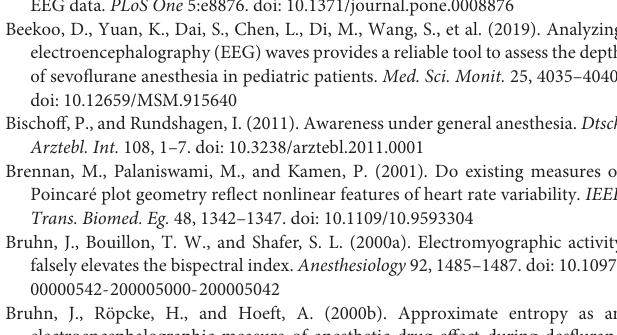
Supplementary Figure 1 | Total EEG power and Poincaré plot parameters throughout the time course from the hypnotic condition to the awake state in anesthetized patients. (A) Total preprocessed EEG power after passing through one of five bandpass filters, (B) SD1/SD2 of the Poincaré plot of the preprocessed EEG signal after passing through one of six bandpass filters, (C) Area of the Poincaré plot (PP A ) of the processed EEG signal after passing through one of six bandpass filters. Supplementary Figure 2 | Relationships of Poincaré plot parameters with BIS and etAG. (A) The relationships of Poincaré plot SD1/SD2 with BIS and etAG. (B) The relationships of Poincaré plot Poincaré plot area ratio (PP AR ) with BIS and etAG. Supplementary Figure 3 | Case-by-case plots of time-course change of PIS and BIS, and linear regressions between PIS and BIS. (A) Adult sevoflurane (adult _ SEV ) group. (B) Adult sevoflurane (adult _ DES ) group. (C) Adult sevoflurane (ped _ SEV ) group. Supplementary Table 1 | Detailed information about patients and anesthesia management. Supplementary Table 2 | Comparison of changes in EEG parameters. (A) The comparison between three groups. (B) The comparison in the all _ combined group. Supplementary Table 3 | Evaluation of linear regression of the three groups. Supplementary Data Sheet 1 | The example codes of Poincaré plot parameters – calculations with sample data using Python in Jupyter Notebook, and Processing. Supplementary Video Clips (Separate files, three clips) | one case from each group, 10 min movie clips: Three representative cases from each group are shown as movie clips (35–36 s), which were displayed by decoding from the recorded binary files under “REVIEW mode” of the EEG analyzer and illustrate a 10 min period from the hypnotic state to arousal. The movie clips include the screen of the EEG analyzer (ver. 49_SR), including the Poincaré plot of processed EEG through specific bandpass filters and the EEG power spectrum. (Please ignore the Fc-PIS values on the screen because the algorithm for the calculation of Fc-PIS value was not optimized when we recorded the analyses. Fc-PIS: frequency analysis-cooperated Poincaré plot-integrated